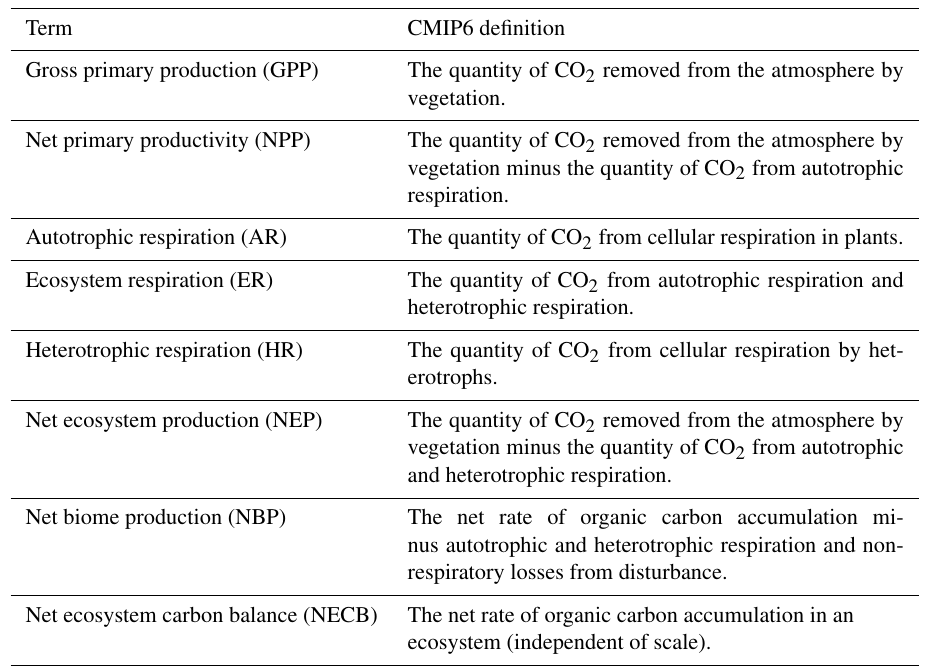
Table 2. Terms associated with terrestrial biogeochemical cycles and their definitions as used by participants. Term CMIP6 definition Gross primary production